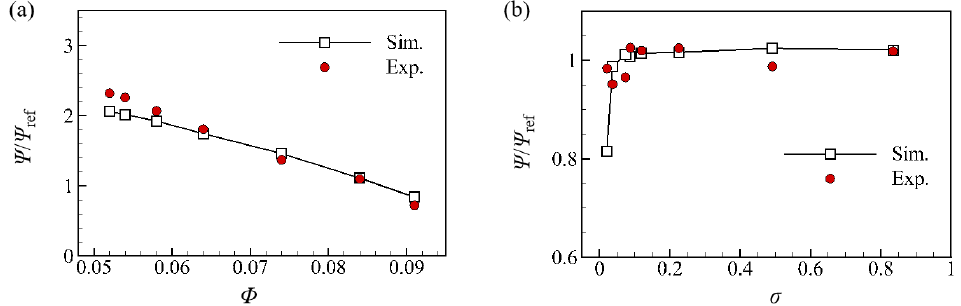
Figure 7. Performance comparison between experiment and simulation for Model C ( τ = 0.5 mm) in terms of: ( a ) non-cavitation performance and ( b ) cavitation